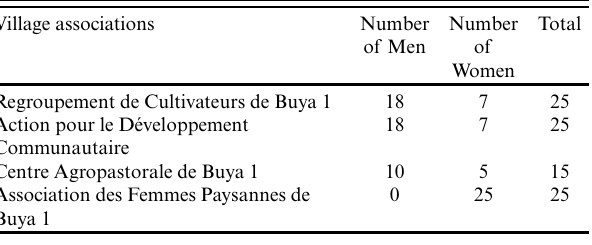
Table 3 . Gendered membership in village associations recognized in the food security project of Buya 1